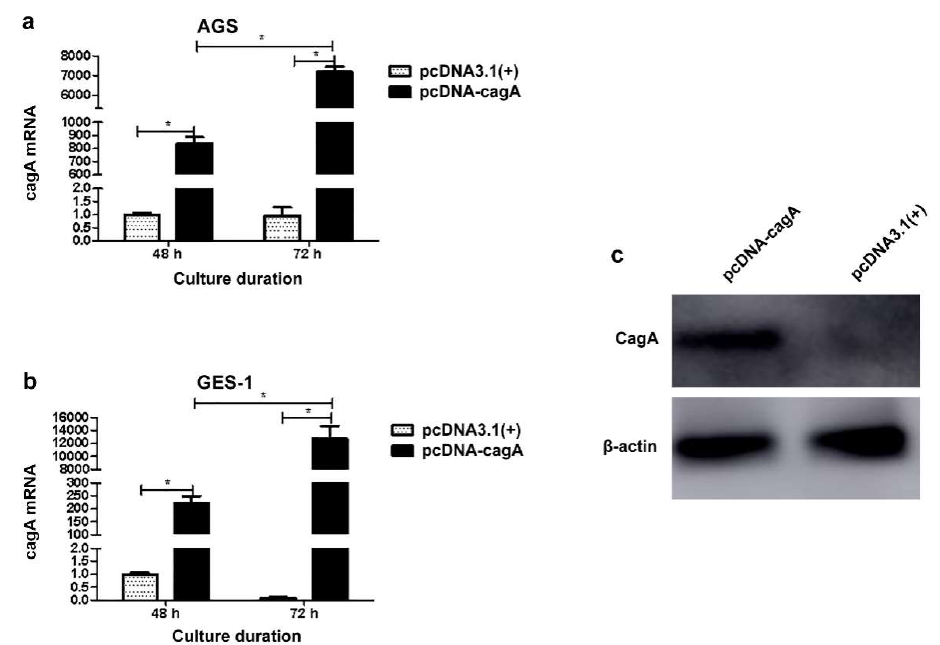
Figure 4. Transfection of the gastric cells and the cagA expression . ( a , b ) cagA mRNA levels in the AGS cells and the GES-1 cells transinfected with pcDNA- cagA and pcDNA3.1(+), respectively. ( c ) Expression of the CagA protein in the GES-1 cells transinfected with pcDNA- cagA and pcDNA3.1(+), respectively. * p < 0.05.